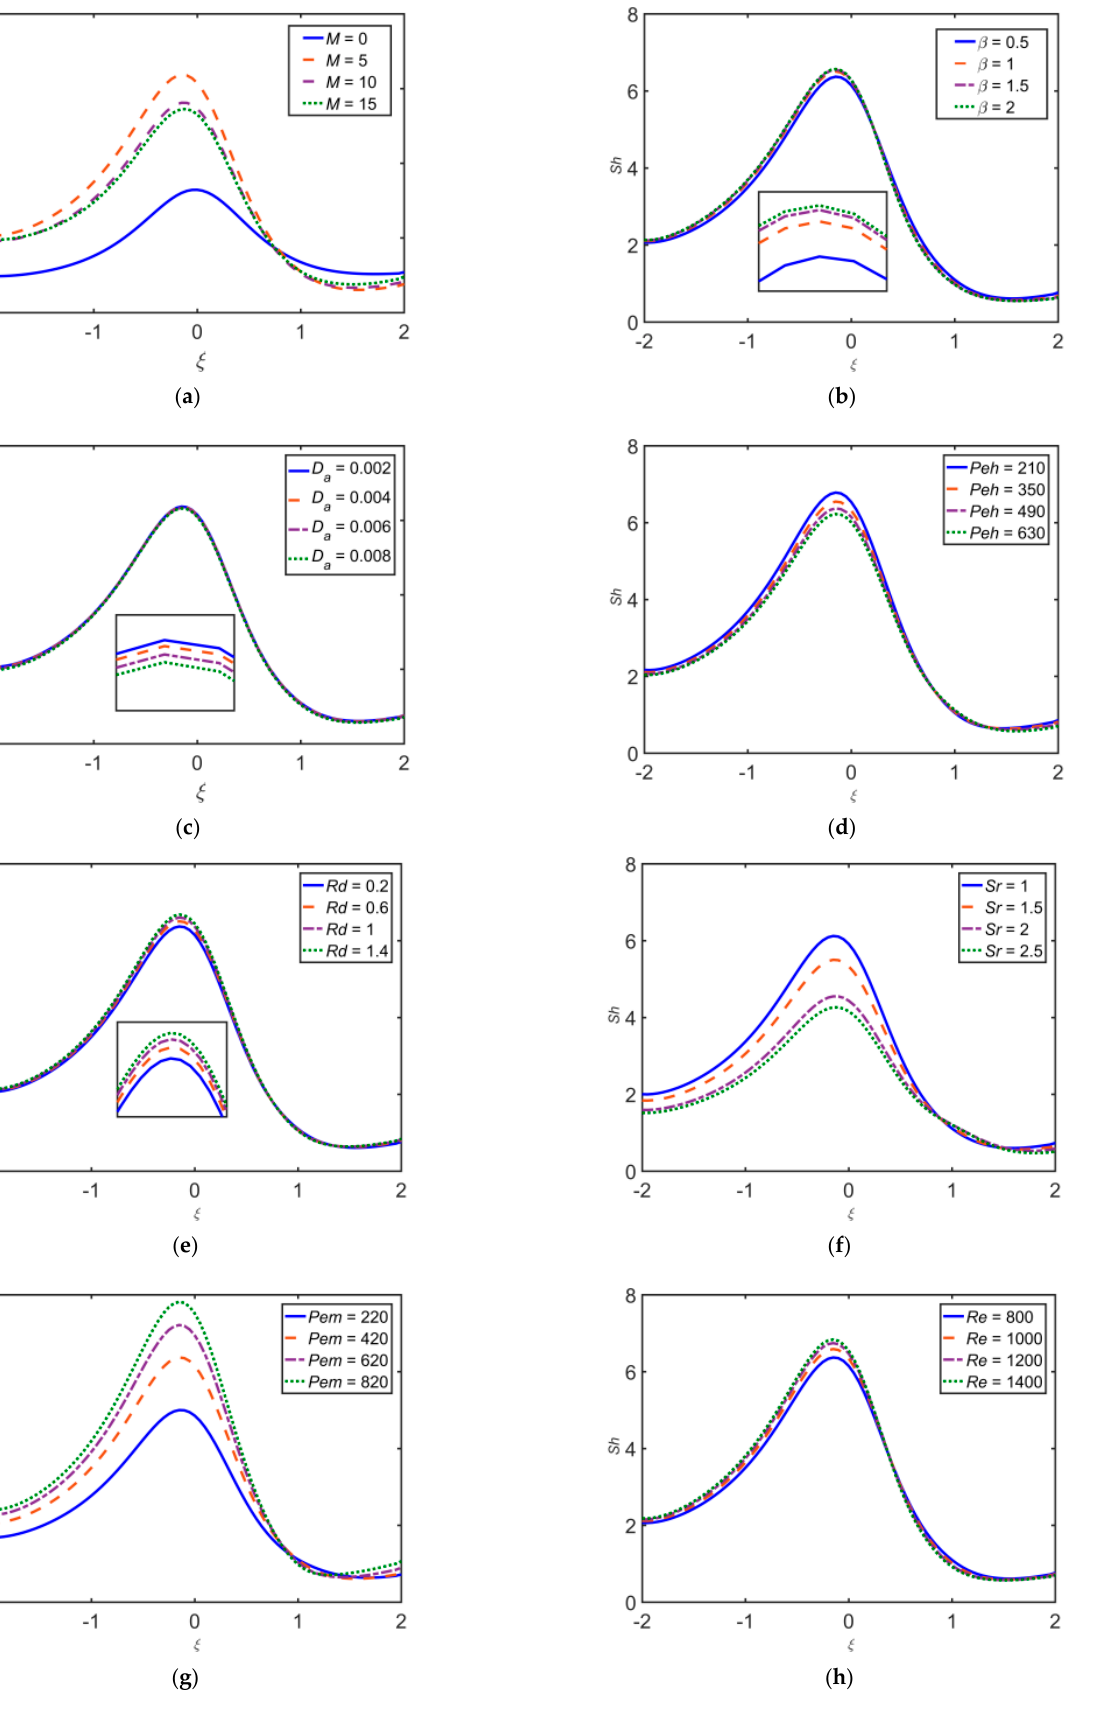
Figure 15. Impact of ( a ) 𝑀 , ( b ) 𝛽 , ( c ) 𝐷 (cid:3028) , ( d ) 𝑃𝑒ℎ , ( e ) 𝑅𝑑 , ( f ) 𝑆𝑟 , ( g ) 𝑃𝑒𝑚 , and ( h ) 𝑅𝑒 on 𝑆ℎ . Figure 16 depicts the effect of various flow governing parameters on skin friction coefficient 𝑆𝑘 . The 𝑆𝑘 has a direct relation with 𝐷 (cid:3028) and 𝑅𝑒 , whereas it has an inverse relation with 𝑀 and 𝛽 .